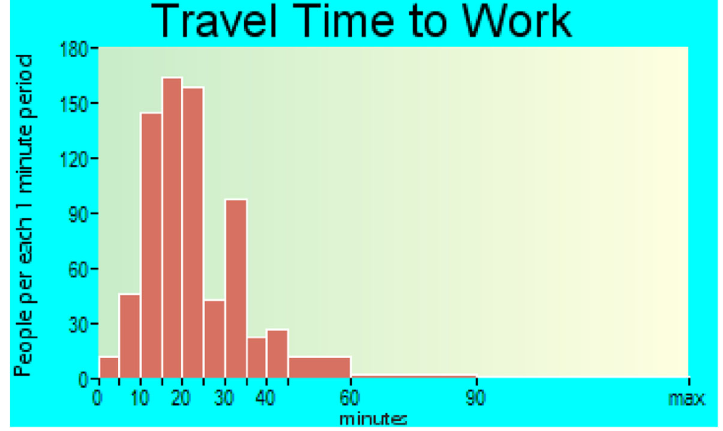
Fig. 3 Residents ’ Travel Time to Work Source: Citi-data,